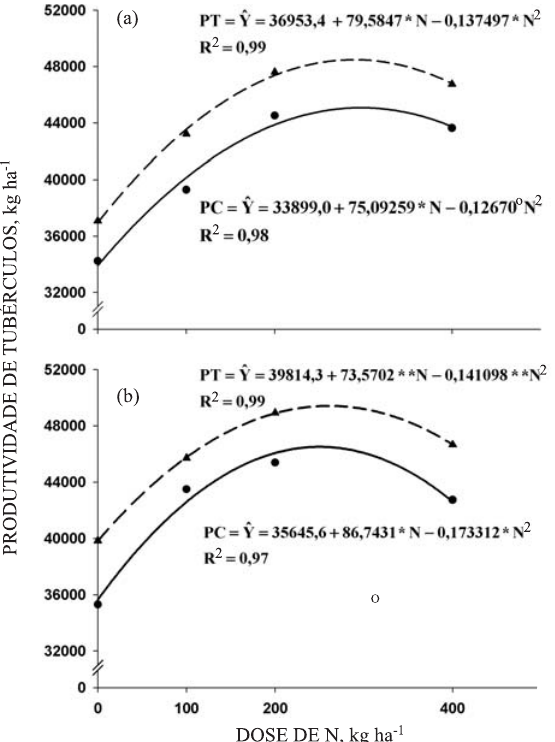
foi o que melhor descreveu o efeito de doses de N sobre Figura 1. Produtividades total e comercial, em